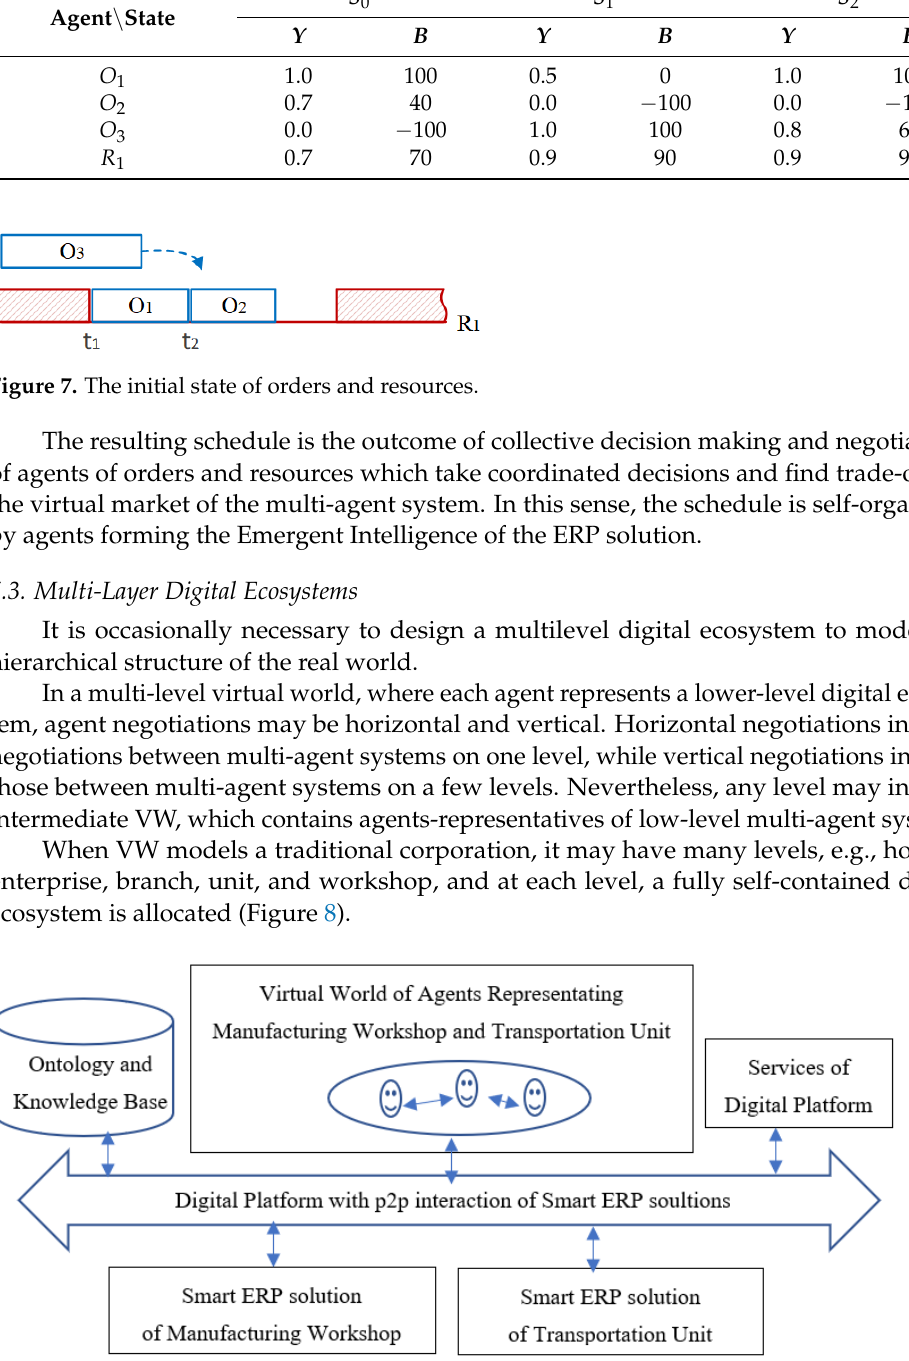
Figure 8. The fragment of smart manufacturing ecosystem which supports p2p interaction of smart ERP solutions for manufacturing and transportation.